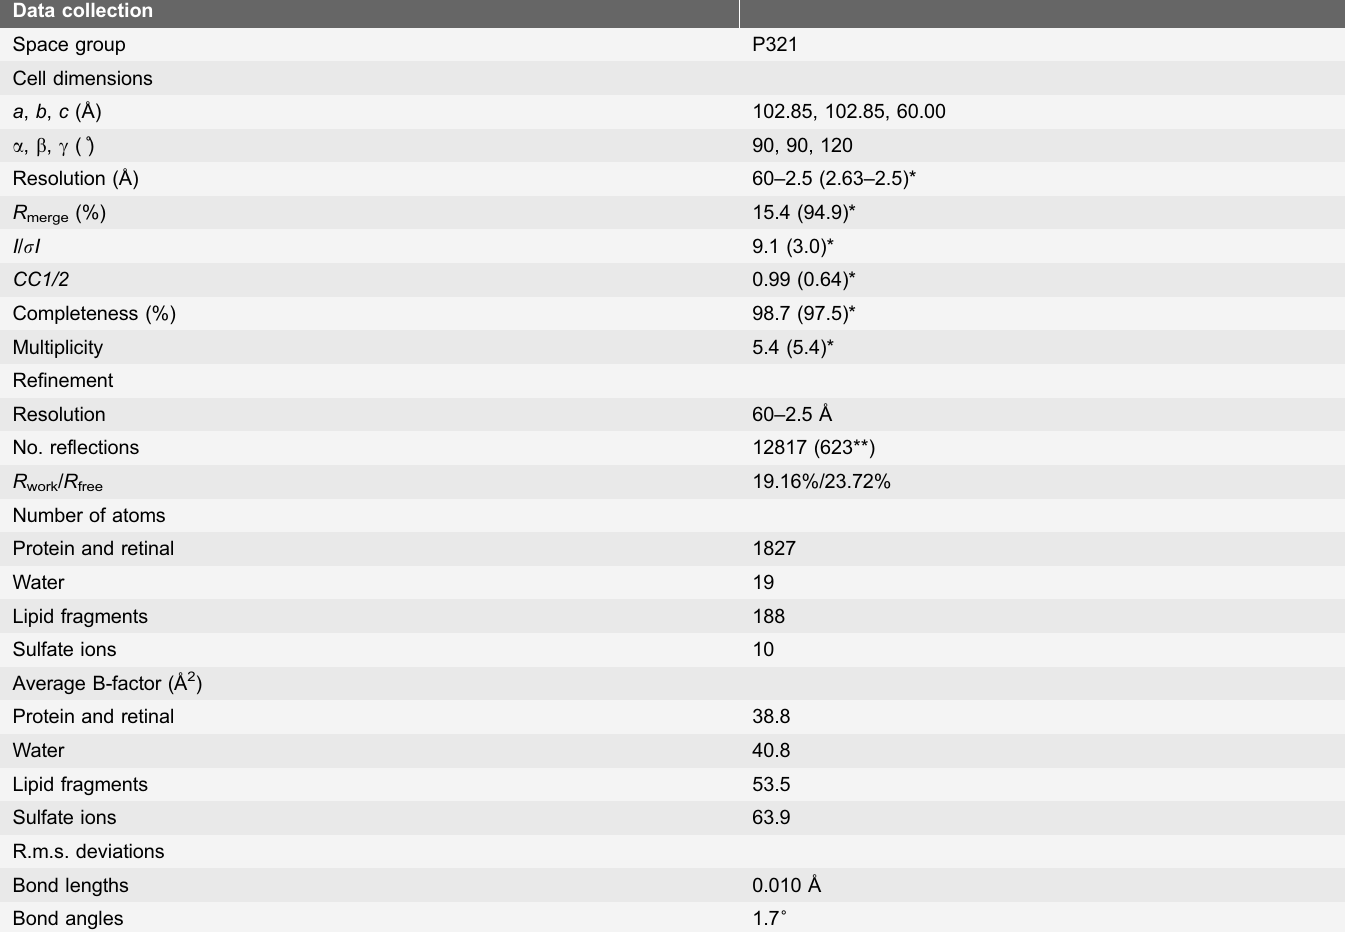
Table 2. Crystallographic data collection and refinement